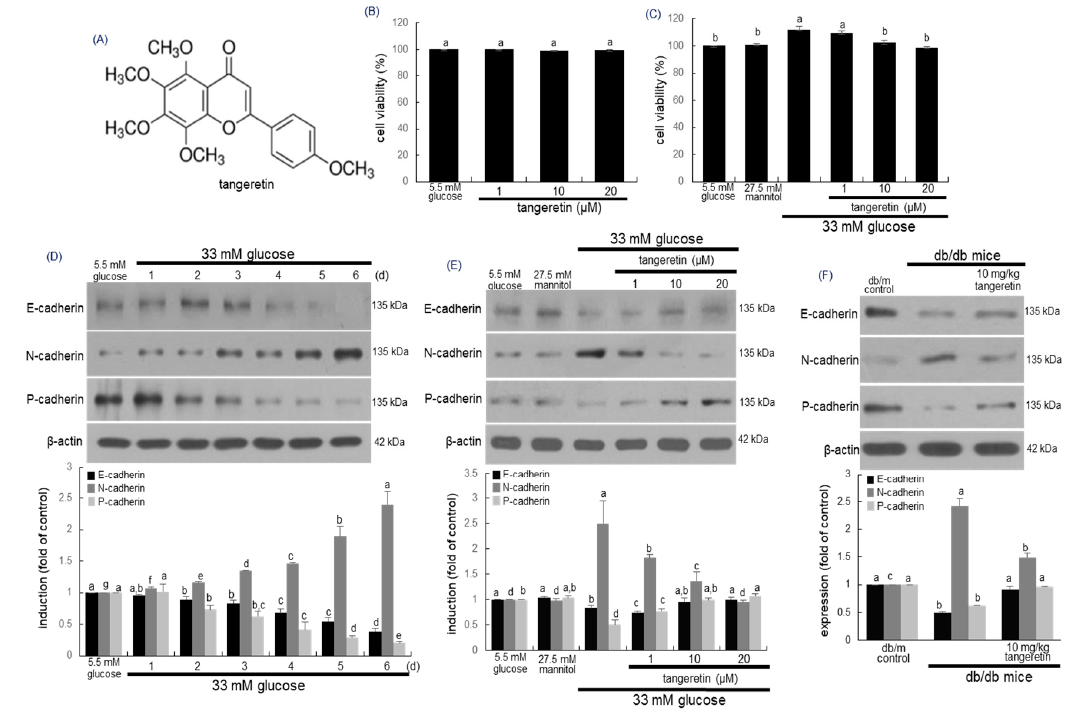
Figure 1. Chemical structure ( A ) and cytotoxicity ( B , C ) of tangeretin, temporal expression of E- cadherin, N-cadherin and P-cadherin in podocytes ( D ) and modulation of their induction by tangeretin in podocytes and diabetic kidney (E and F). Podocytes were incubated with 33 mM glucose in the presence of 1–20 μ M tangeretin for 4 days. Cell viability (mean ± SEM, n = 5) was measured by MTT assay and expressed as percent cell survival relative to glucose controls ( B , C ). The db/db mice were orally supplemented with 10 mg/kg tangeretin for 10 weeks ( F ). Podocyte lysates and kidney tissue extracts were electrophoresed on 8%–10% SDS-PAGE and subject to Western blot analysis with a primary antibody against E-cadherin, N-cadherin and P-cadherin ( D – F ). β -Actin antibody was used as an internal control. The bar graphs (mean ± SEM, n = 3) in the bottom panels represent quantitative results of upper blot bands obtained from a densitometer. Means in bar graphs without a common letter differ, p < 0.05.